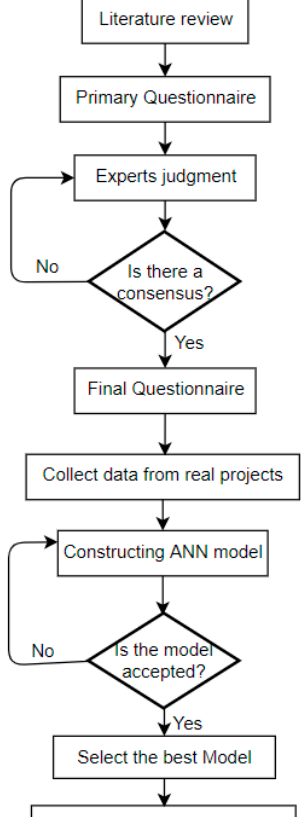
Figure 1. The Methodology of research. Table 9. Classification of overall